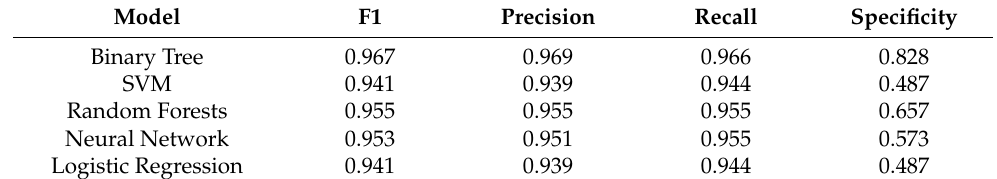
Table 12. Models accuracy metrics average over classes with add_to_cart_direct as target parameter.